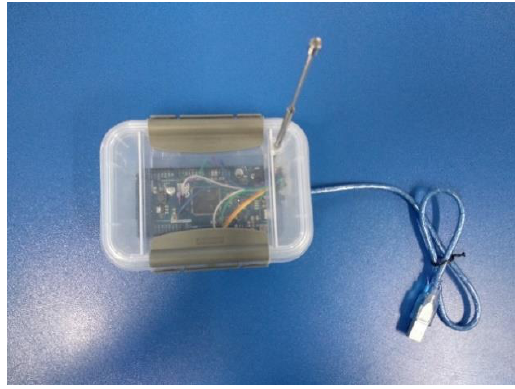
Figure 8. Electrical diagram of the central node.